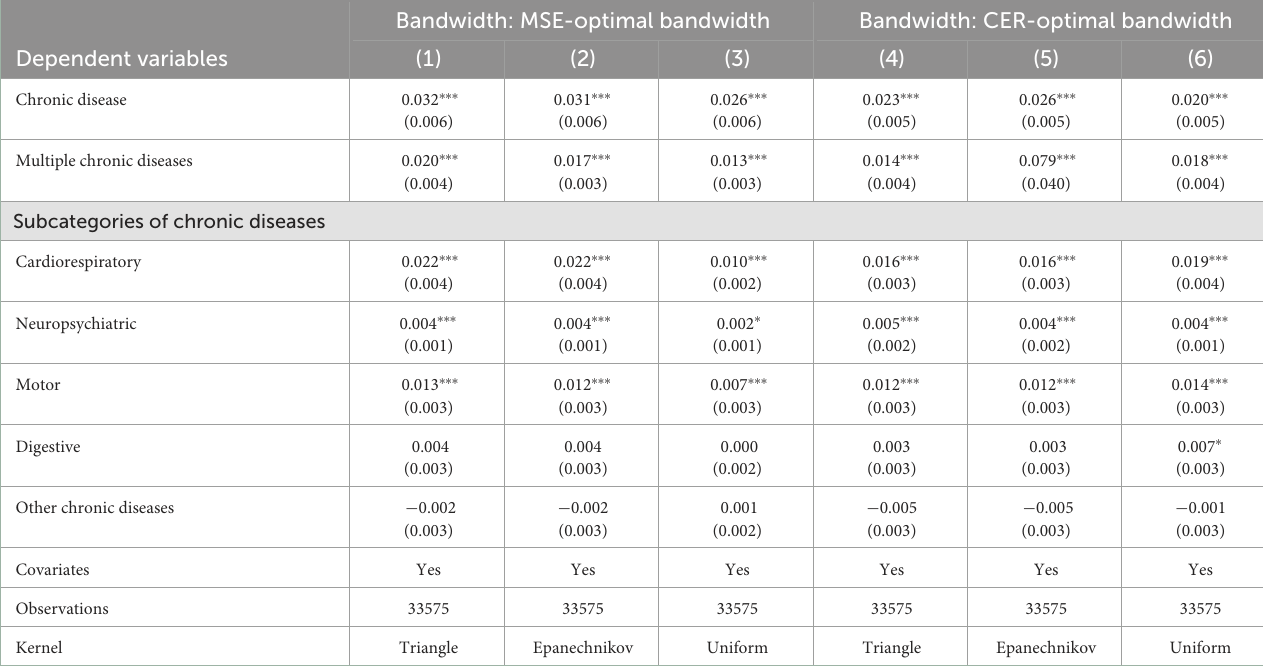
TABLE 5 Effects of alternative bandwidth selection and kernel weighting methods on regression results, nonparametric